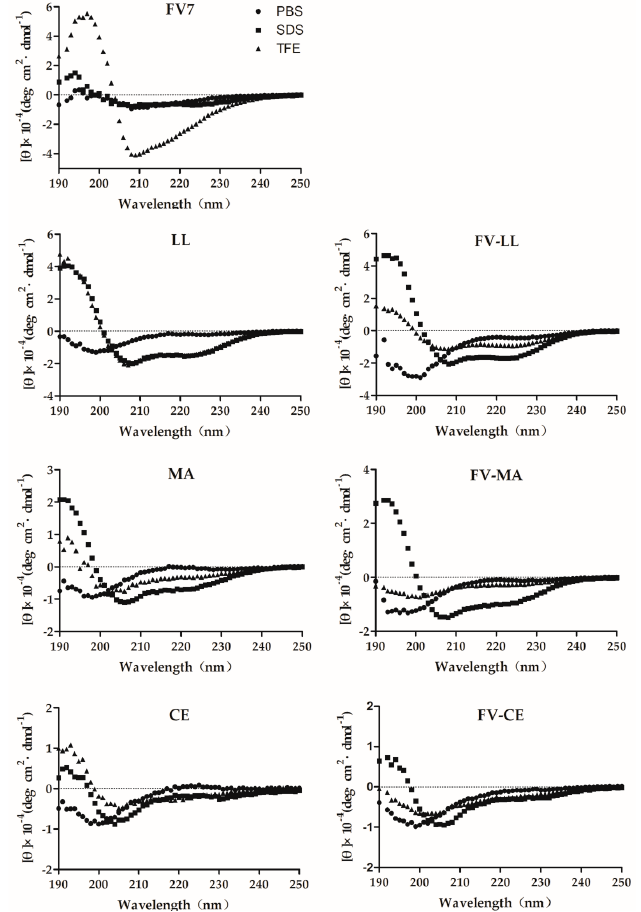
Figure 2. The circular dichroism (CD) spectra of the peptides in 10 mM phosphate-buffered saline (PBS; pH 7.4) ( ● ), 30 mM sodium dodecyl sulfate (SDS) ( ▪ ) and 50% trifluoroethyl alcohol (TFE) ( ▲ ). (PBS; pH 7.4) ( ), 30 mM sodium dodecyl sulfate (SDS) ( (cid:4) ) and 50% trifluoroethyl alcohol (TFE) ( (cid:78) ). The peptide concentration was fixed at 150 μ M. The peptide concentration was fixed at 150 µ